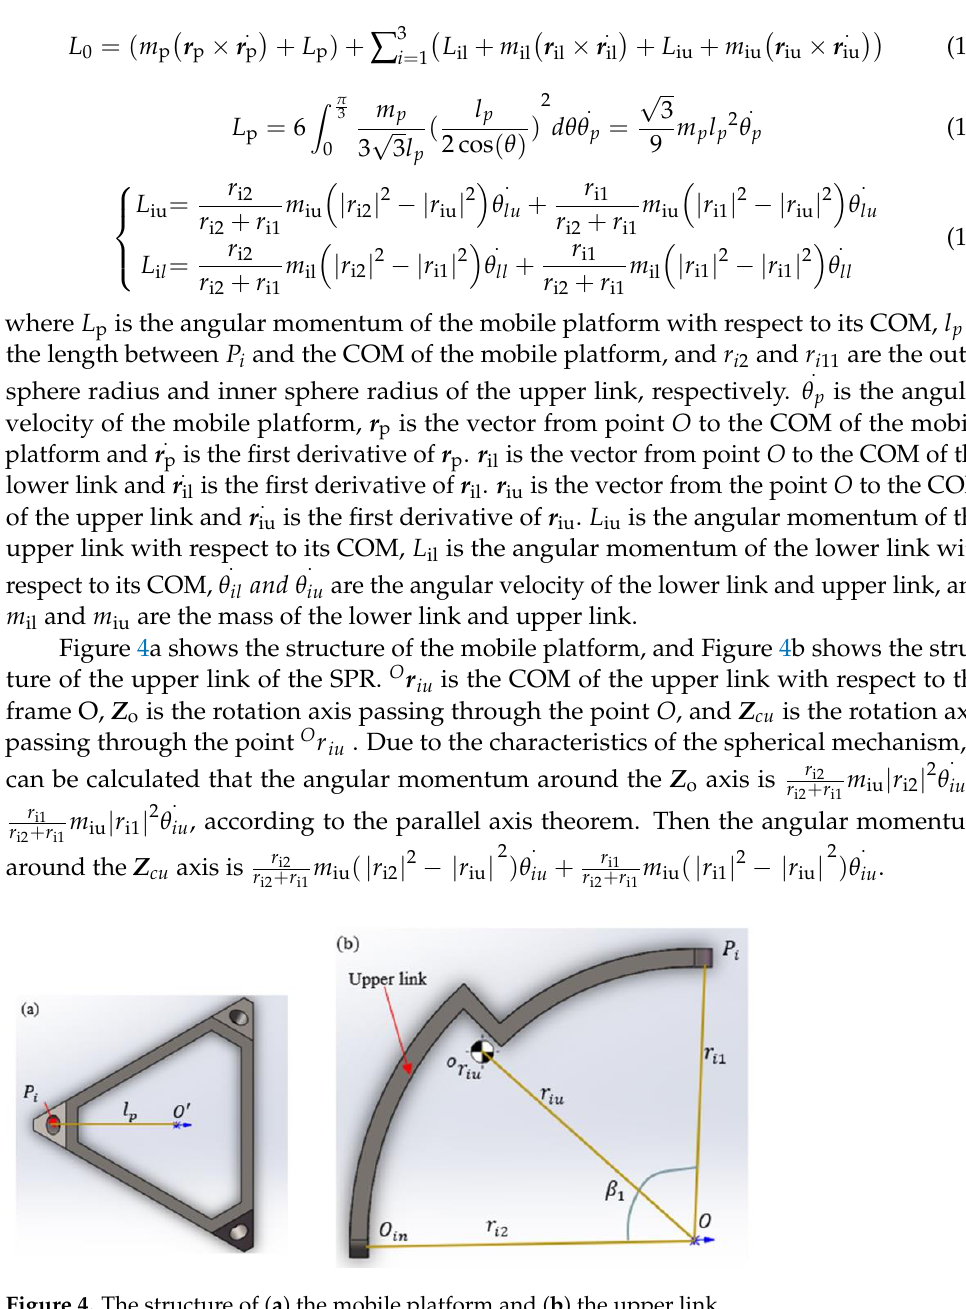
Figure 4. The structure of ( a ) the mobile platform and ( b ) the upper